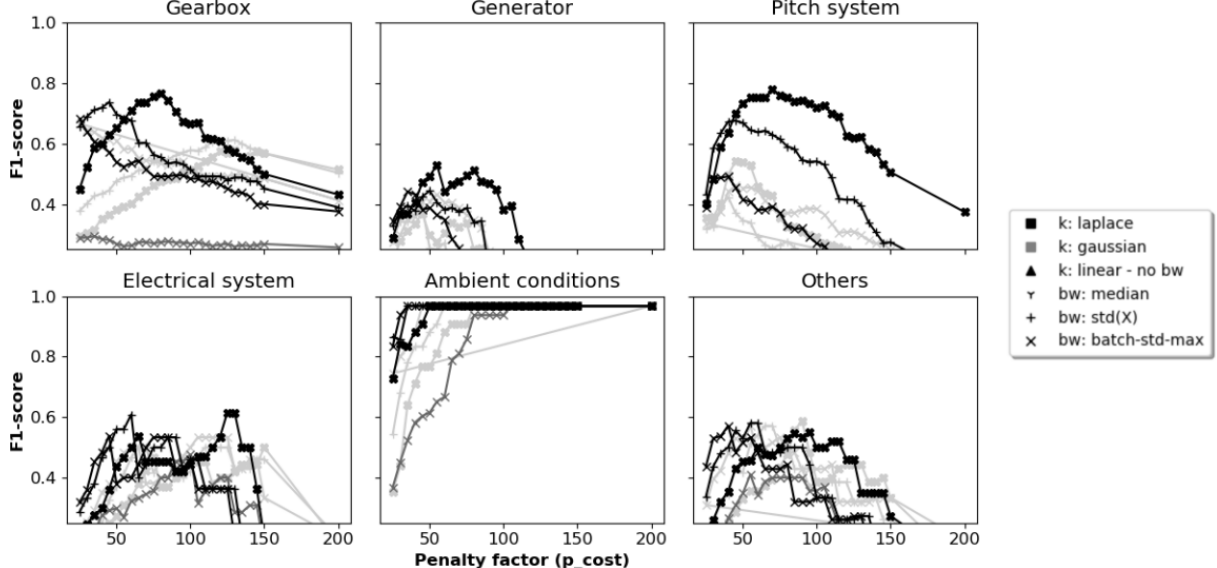
Figure C4. The 1-year signal selection: F1 scores per component for different hyperparameter configurations and penalty